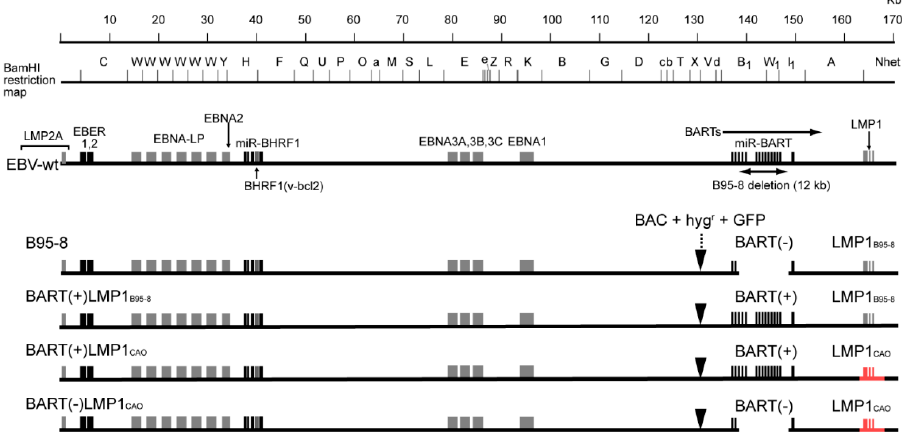
Figure 2. Schematic illustration of the EBV genome and four EBV-BAC clones with different BART miRNA and LMP1 statuses. The linear EBV genome, viral genes, non-coding RNAs (EBV-encoded small RNA (EBER) and BARTs), and viral microRNA genes (miR-BHRF1 and miR-BART) are illustrated. The BamHI restriction map is based on the sequence of a representative EBV strain retaining the BART miRNA locus [30]. Schematic illustration of four EBV-BAC clones (in linearized form) are shown (bottom); LMP1 CAO is shown in red, and the presence or absence of the BART miRNA cluster is illustrated. The insertion site for a BAC vector sequence, a hygromycin resistance gene (hyg r ) and a GFP gene is indicated by arrowheads. DNA size is indicated at the top.